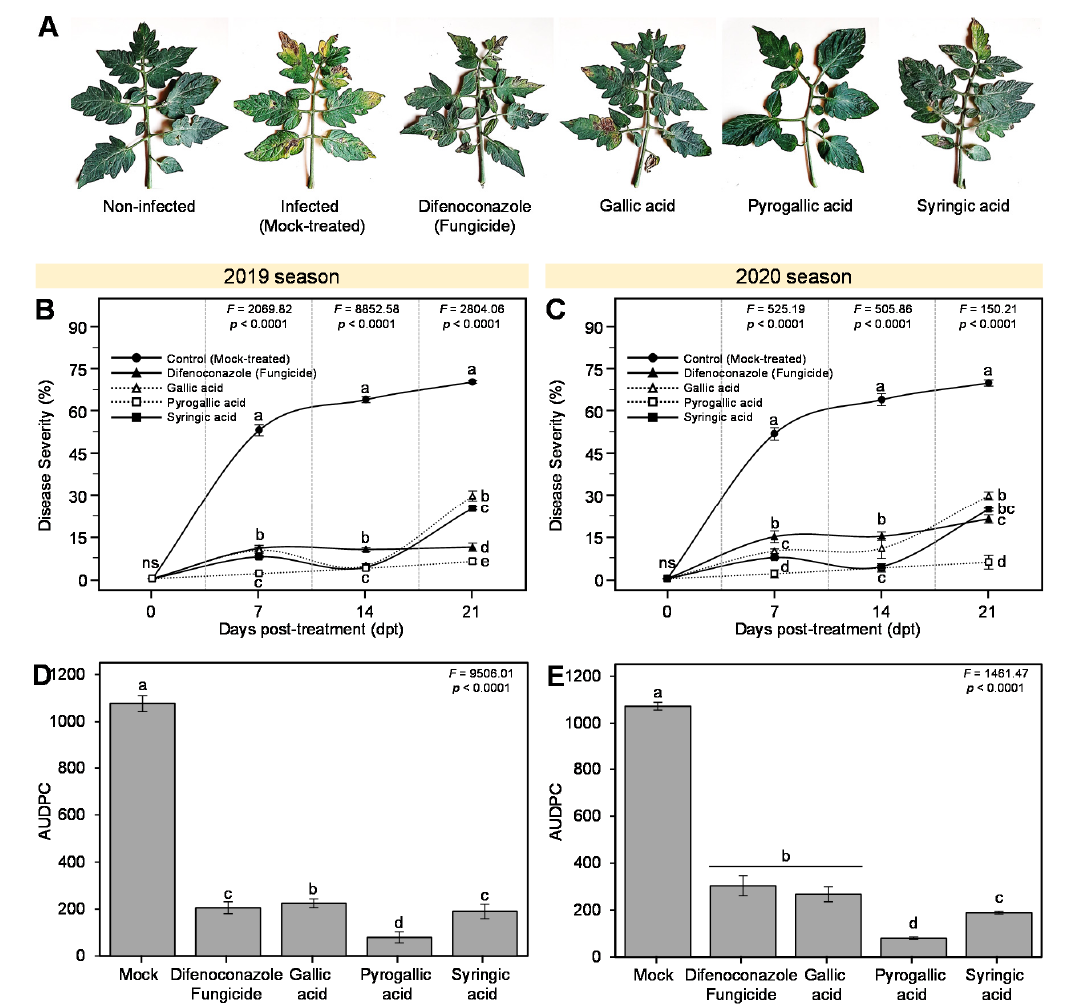
Figure 4. Effects of gallic acid and its derivatives on the development of early blight disease caused by A. solani on tomato plants (Super strain B–F 1 hybrid) under greenhouse conditions ( n = 6). ( A ) Typical symptoms of early blight disease on tomato leaves at 7 days post-treatment (dpt) with 100 ppm of gallic acid and its derivatives. ( B , C ) Disease progress curves of early blight disease on tomato leaves after the treatment with gallic acid or its derivatives during 2019 and 2020 seasons, respectively. Values represent means of six replicates, while whiskers reflect the standard deviation (Means ± SD). Different letters indicate statistically significant differences among treatments, while “ns” or the same letter signify no significant differences among treatments at the same time point. ( D , E ) The area under disease progress curve (AUDPC) of early blight disease on tomato leaves after the treatment with gallic acid or its derivatives during 2019 and 2020 seasons, respectively. Bars represent means of six replicates, while whiskers reflect the standard deviation (Means ± SD). Different letters indicate statistically significant differences among treatments using the Tukey–Kramer honestly significant difference test (Tukey HSD; p < 0.05).